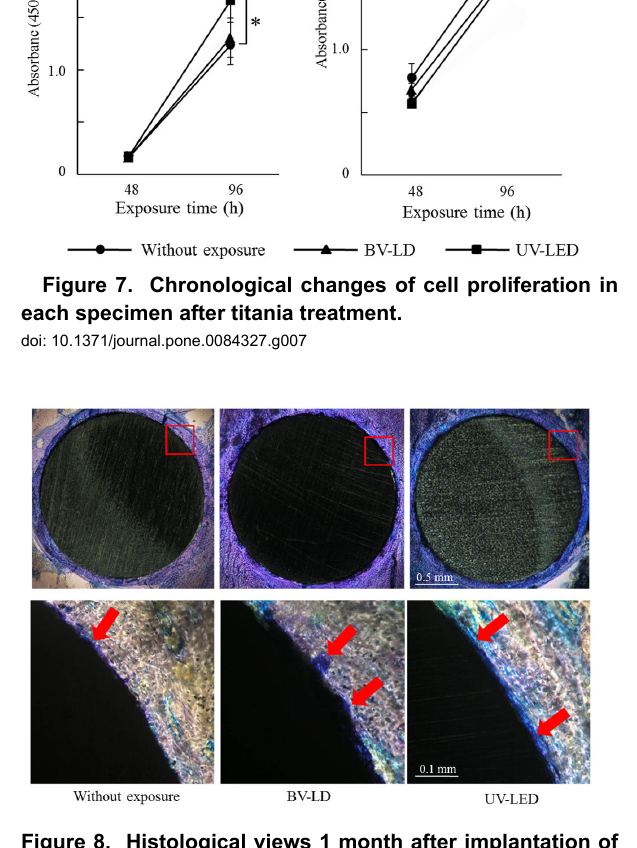
Figure 8. Histological views 1 month after implantation of titania-treated specimens. Arrows: new bone formation.